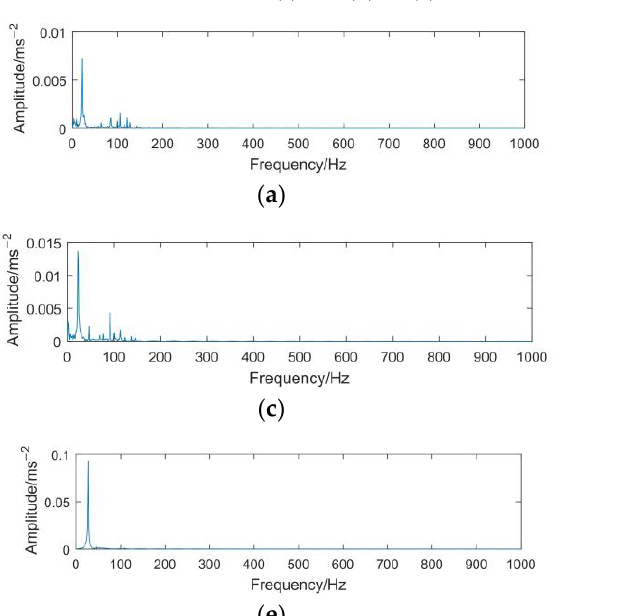
Figure 12. The time-domain waveform of a group of the rotor reconstructed signal: ( a ) Nor, ( b ) BBLF, ( c ) MF, ( d ) IF, ( e ) LRIF.